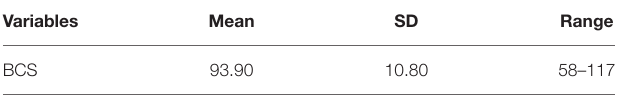
TABLE 2 | Descriptive statistics of the BCS scores in study 2.